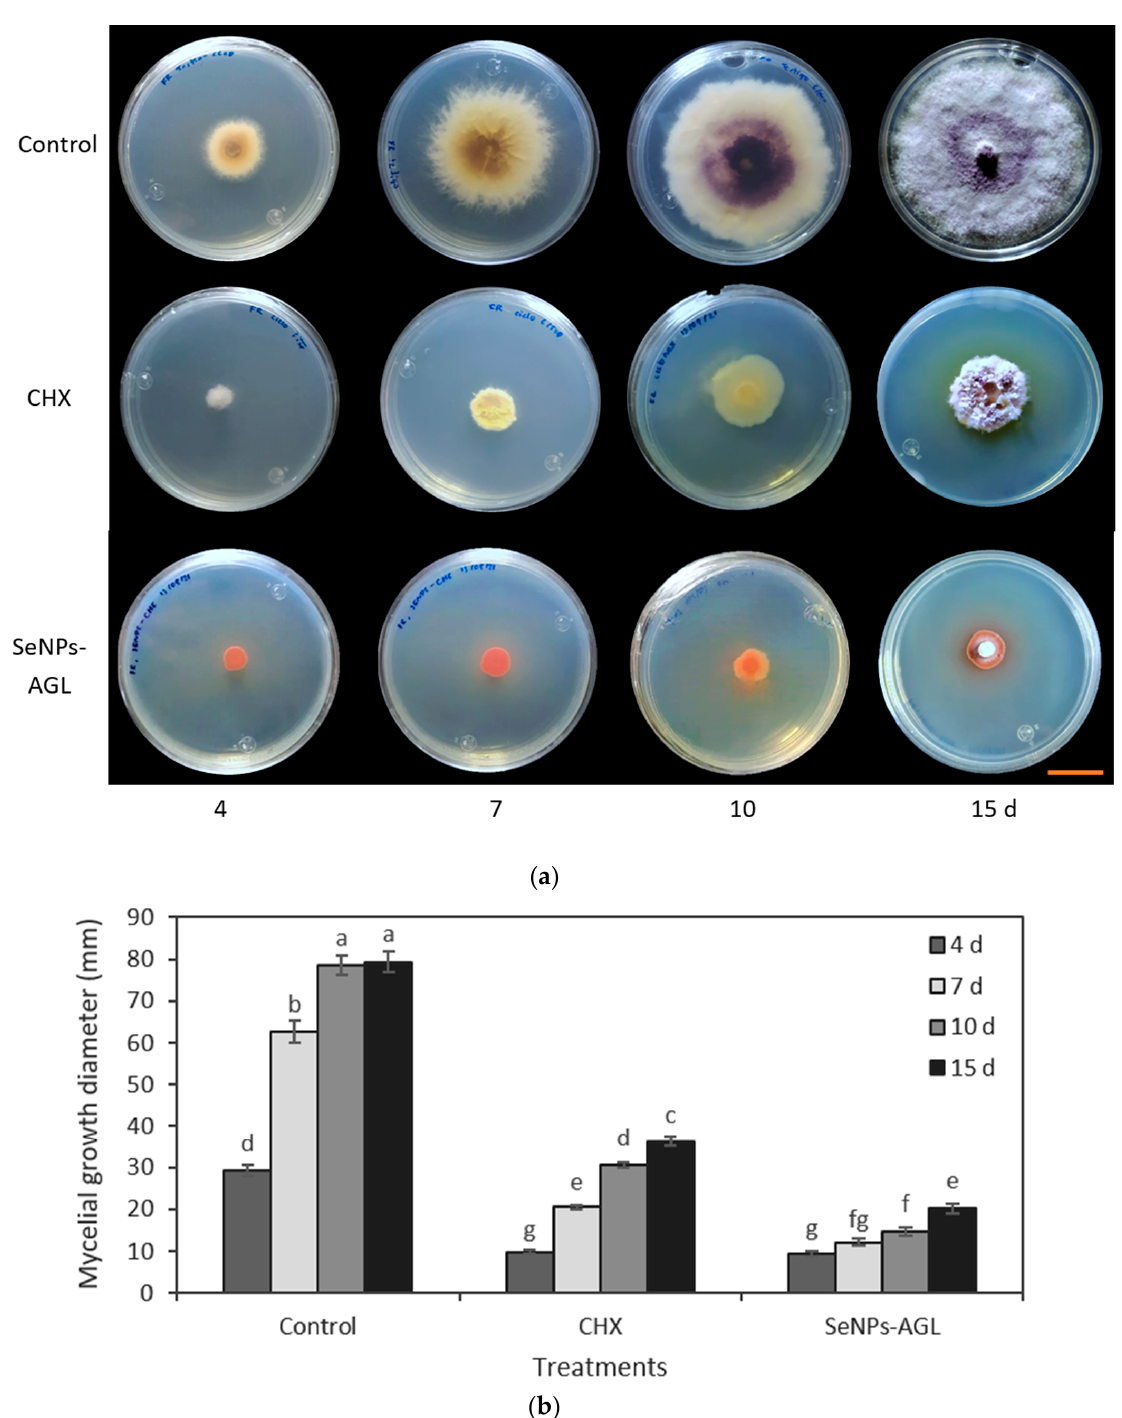
Figure 4. Antifungal activity of SeNPs synthesized with A. glaucum (AGL) extracts against F. oxysporum . ( a ) Representative photograph of the antifungal activity test under different treatments over time. SeNPs and CHX were applied at 1.7 mg/mL and 2.5 mg/mL, respectively. The scale bar is 2.5 cm. ( b ) Comparison of means of the effect of the SeNPs synthesized with extracts of A. glaucum against F. oxysporum . Mean values ± ee. Different letters indicate statistically significant differences according to Duncan’s test ( α = 0.05), p < 0.0001.